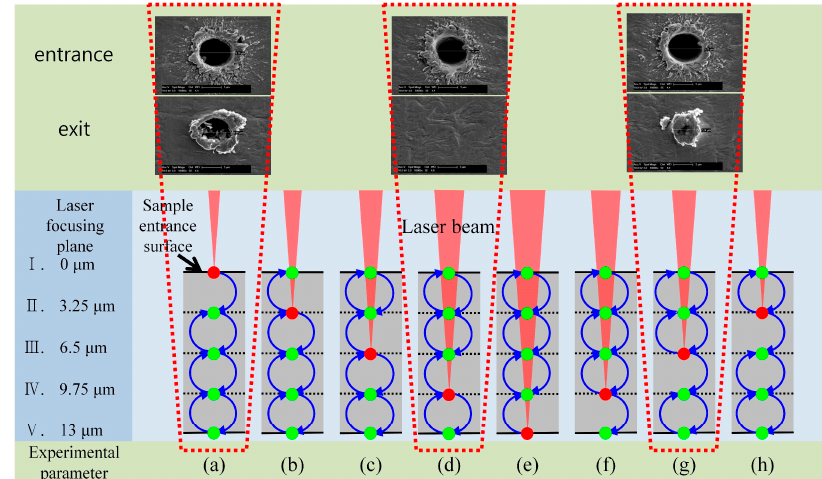
Figure 3. Schematic diagram of the experimental procedure and typical scanning electron microscope images of the entrance and exit holes. Red dots indicate the first pulse while green dots indicate the remaining 2–8 pulses. The blue arrows indicate the focus direction of motion (e.g., parameter a: I → II → III → IV → V → IV → III → II).